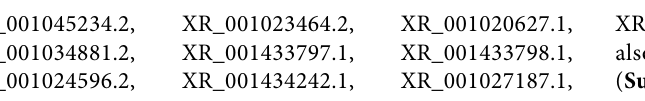
Frontiers in Molecular Biosciences |